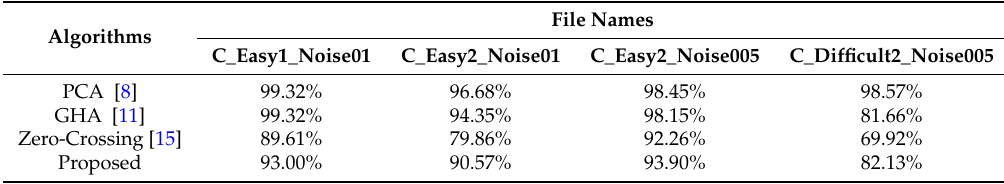
Table 10. The CSRs of the FCM algorithm by clustering the feature vectors produced by various feature extraction algorithms. The spike source data are obtained from the wave_clus database